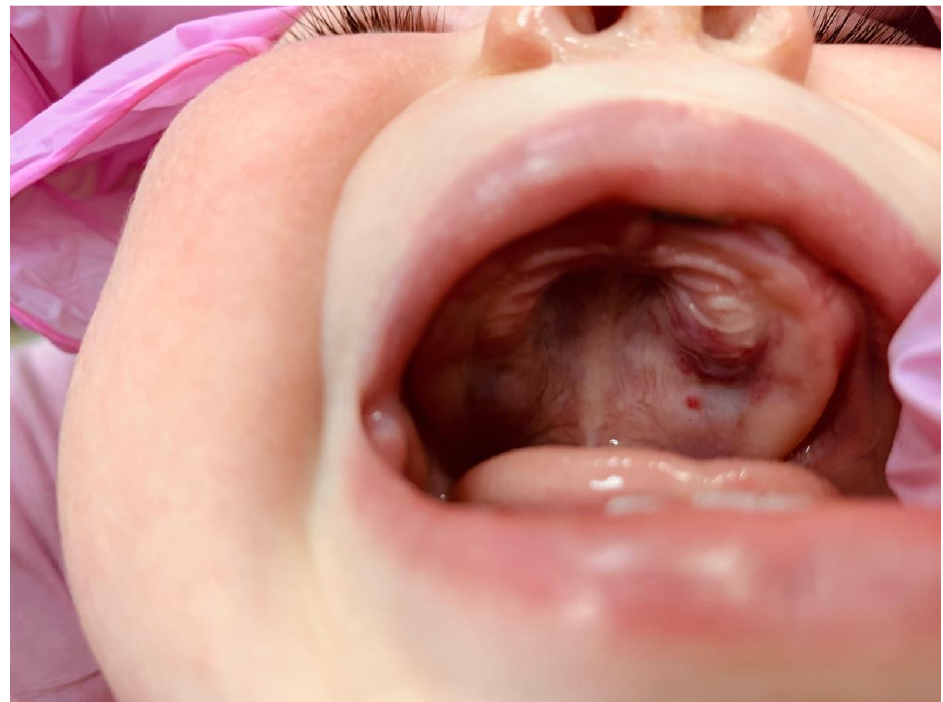
Figure 3. Intraoral photograph showing a 11-month-old Caucasian female with a 3.5 cm × 3.5 cm well circumscribed, non-contiguous, red/crimson macule with a 1 mm white dot at the center. It is located on the posterior portion of the upper left alveolar ridge, spanning to the mid-palate, and is anterior to the smaller red macule.